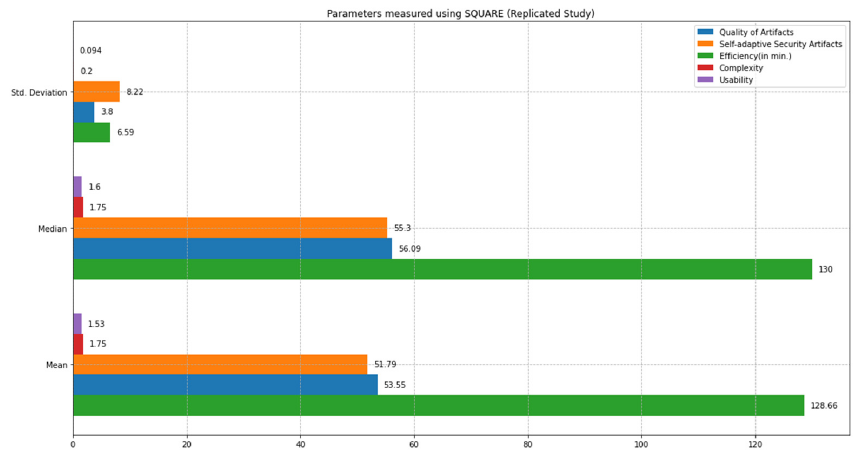
Figure 18. Statistical test for parameters measured using SQUARE approach for replicated study.